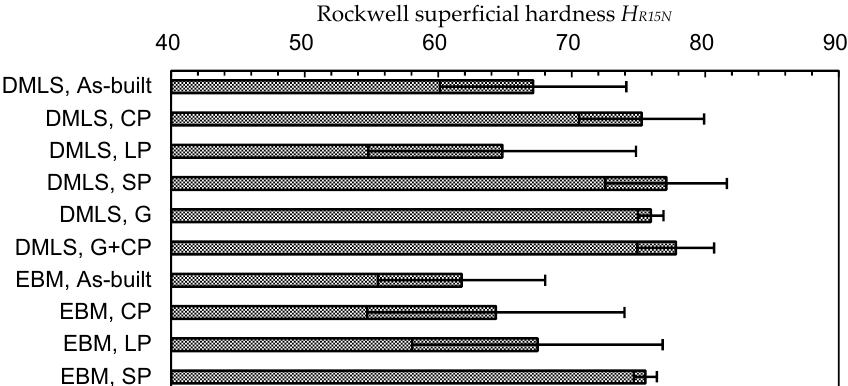
Figure 8. Surface hardness of the as-built Ti6Al4V manufactured by DMLS and EBM and the Ti6Al4V manufactured by DMLS and EBM through cavitation peening (CP), laser peening (LP), shot peeing (SP), grinding (G), and cavitation peening after grinding (G + CP).